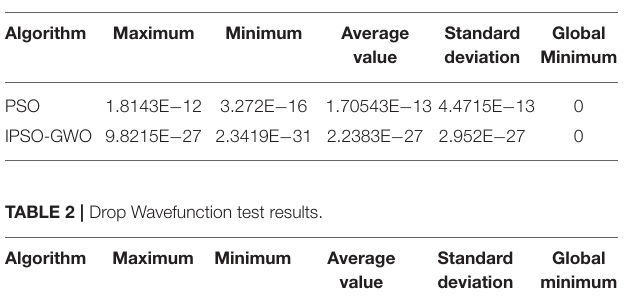
TABLE 6 | Rastrigin function test results.